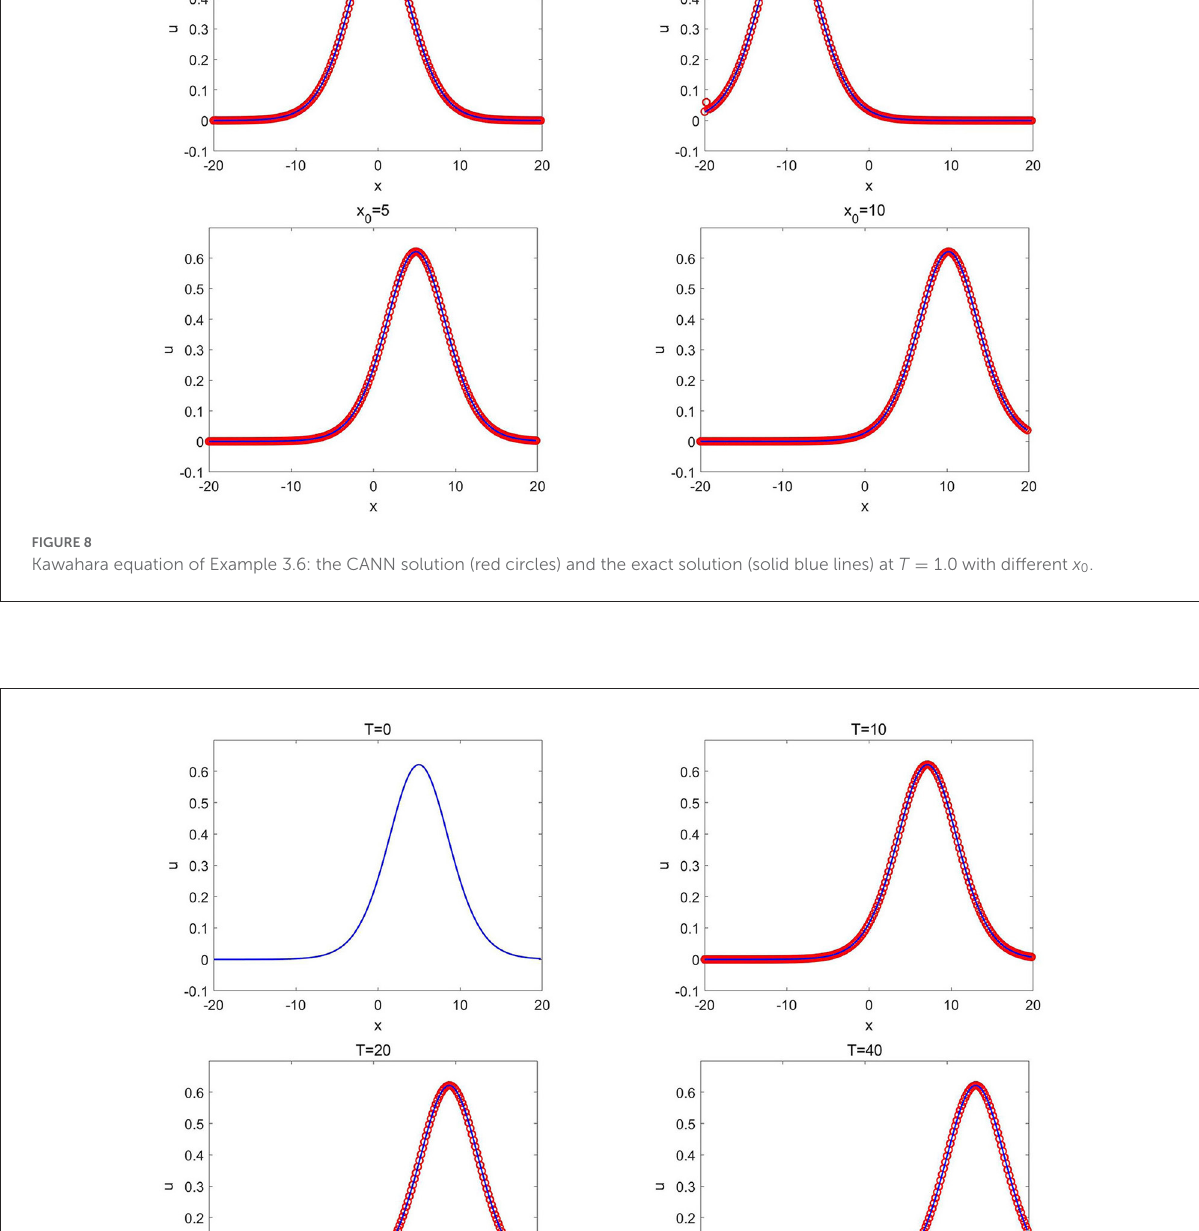
FIGURE9 Kawahara equation of Example 3.6: the CANN solution (red circles) and the exact solution (solid blue lines) at different T with x 0